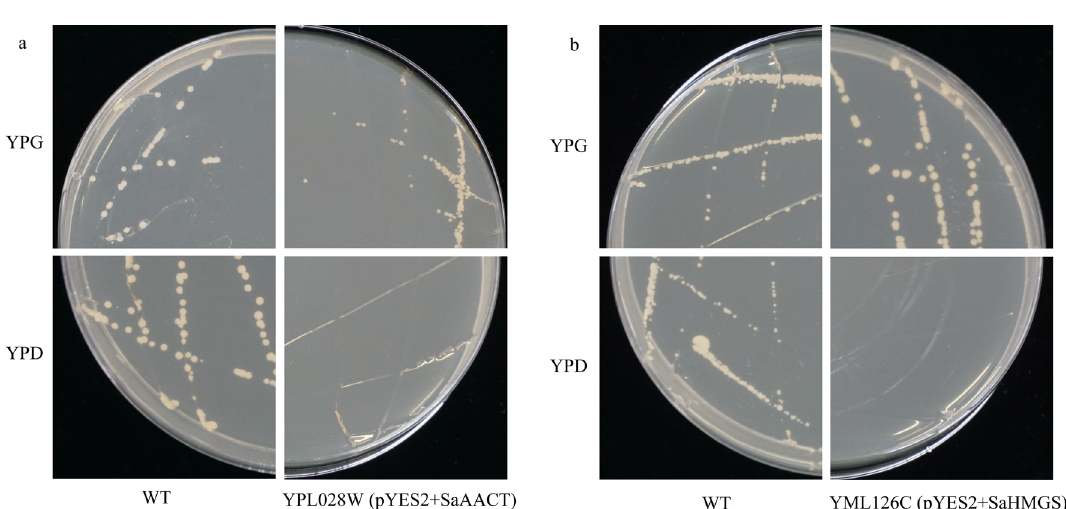
Figure 6. Functional complementation of two Santalum album genes ( a : SaAACT ; b : SaHMGS ) in yeast ( Saccharomyces cerevisiae ). WT, wild